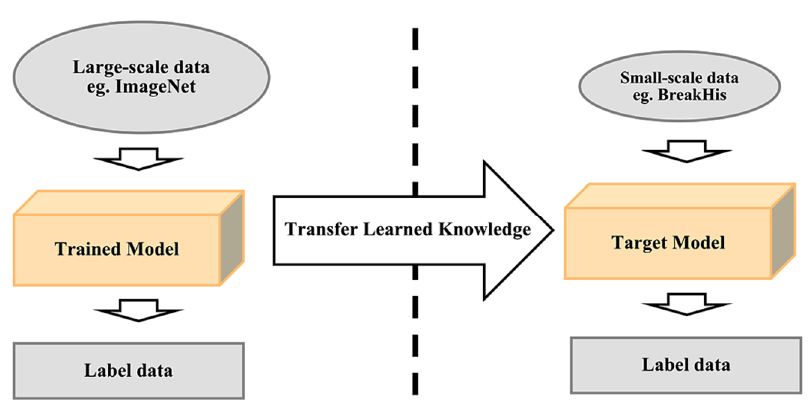
Figure 14. Transfer learning approach.